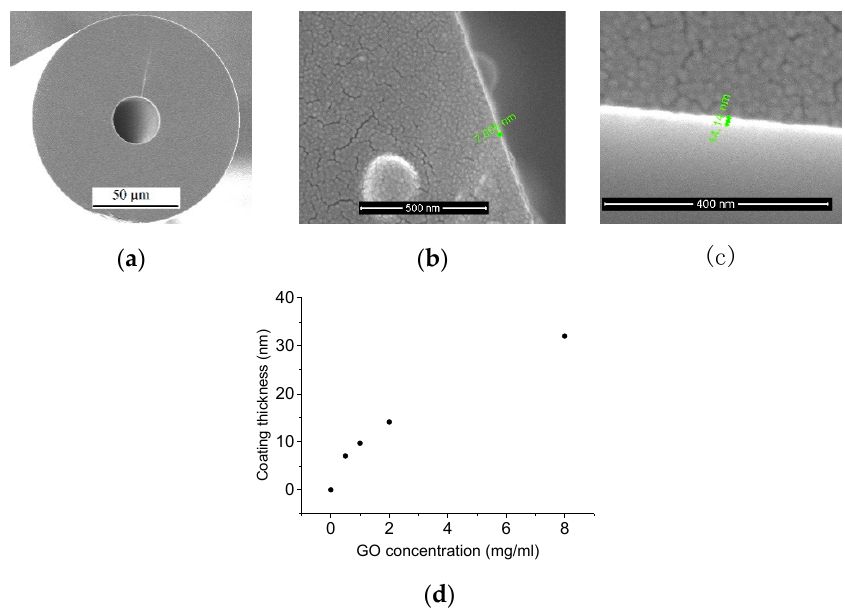
Figure 4. SEM image of the graphene oxide (GO) coated HCF ( a ) cross section, and the coating thickness of the GO layer with GO concentrations of ( b ) 0.5 mg / mL and ( c ) 2 mg / mL, and ( d ) the relationship between the coating thickness and GO concentration.